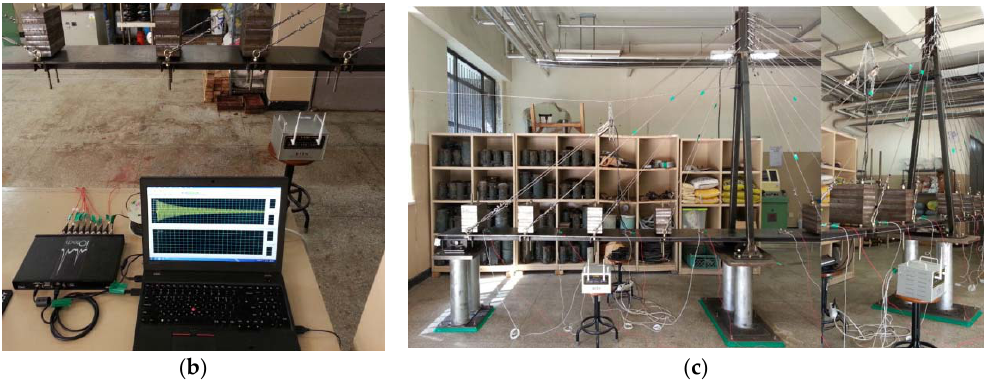
Figure 9. Modal test of model bridge: ( a ) Hammer and sensor location; ( b ) wired measurement system; ( c ) wireless measurement system (WUMS).